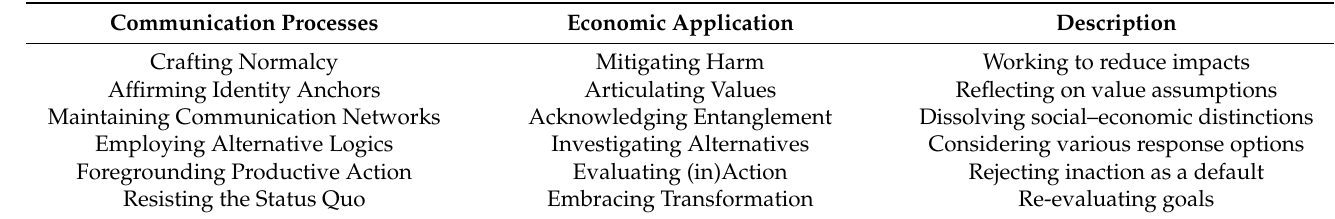
Table 2. Summary of communication theory of resilience processes, adaptation, and